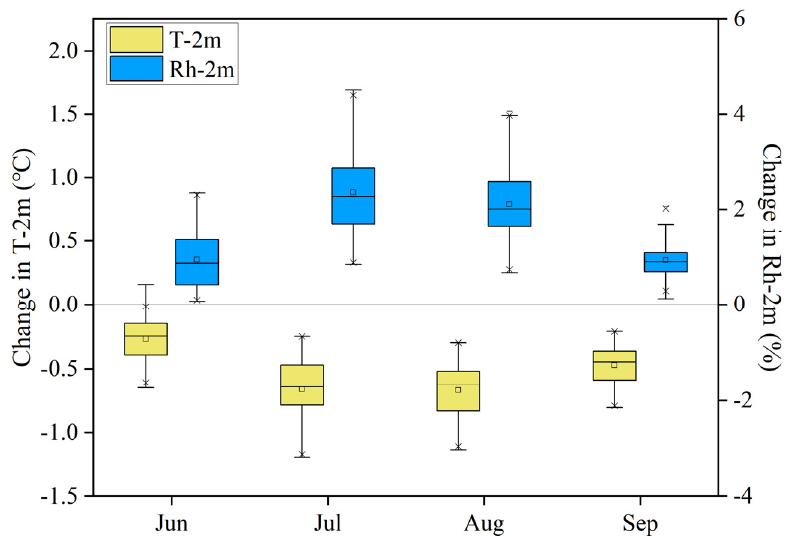
Figure 8. Differences (SEN-CTL) in simulated regional mean air temperature and relative humidity for the grids with dominant land use types converted from saline-alkali land to wetland for June, July, August, and September in western Jilin.